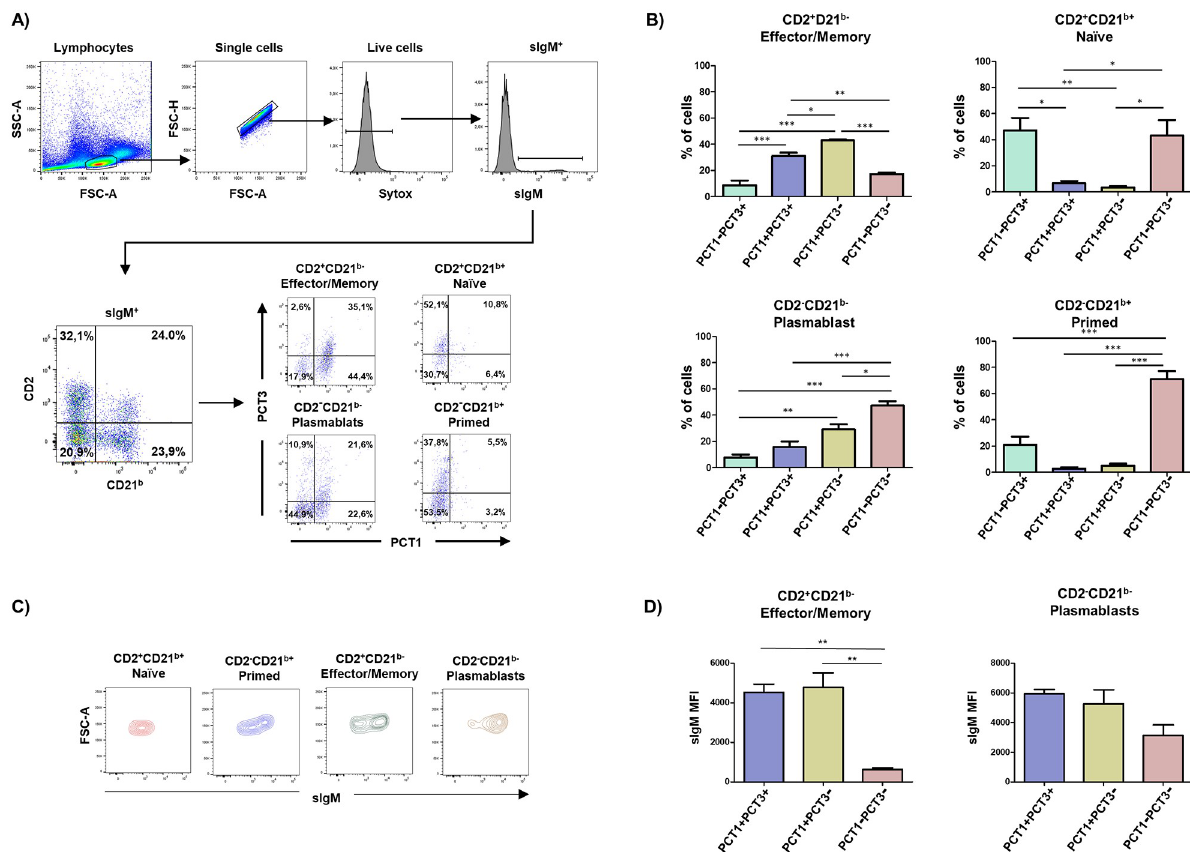
Fig 1. PCT1 and PCT3 mAb reactivity on sIgM + B cell subsets. A) Blood lymphocytes were gated according to their FSC-A/SSC-A profiles. After excluding doublets and dead cells, sIgM + cells were gated and analysed for the expression of CD2 vs CD21 b . CD2/CD21 b defined cell subsets were further subgated for analysis of PCT1 vs PCT3 expression. Numbers indicate the percentage of cells within the respective quadrants. B) Graphs show average ± SEM of the percentage of cells in each cell subset analysed in 4 independent experiments carried out with cells from different animals. C) Contour-plots represent FSC-A vs. sIgM in the indicated B cell subsets. D) Graphs show average ± SEM of the sIgM mean fluorescence intensity of 4 independent experiments. One way ANOVA followed by Bonferroni adjustment was used to assess statistically significant differences. Symbols used: � , p � 0.05; �� , p � 0.01, ��� , p �